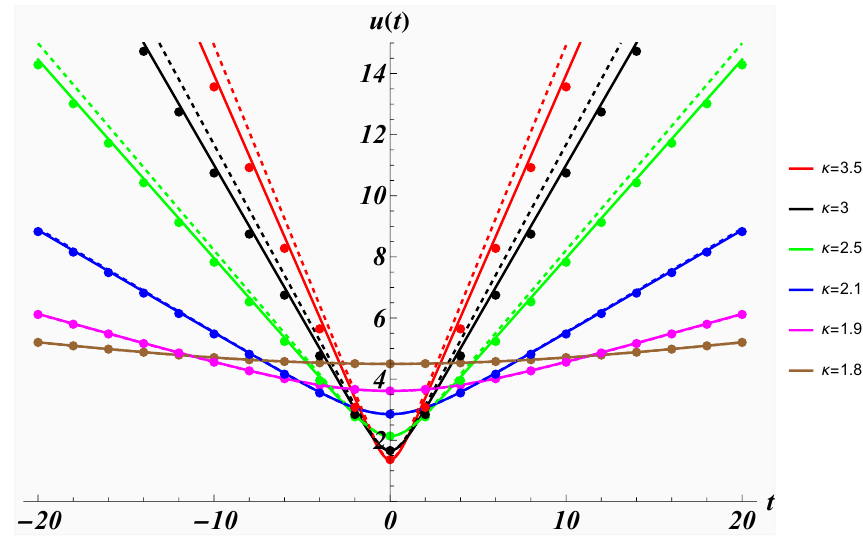
Figure 2 . Collective coordinate u ( t ) as solution of the Euler-Lagrange equation (2.10) for the reduced theory (dashed lines) versus the “exact” expression (3.29) (solid lines) read off from the comparison of the exact two-soliton solution (3.24) with a superposition of two one-soliton solu- tions (3.20) or obtained from the singularity structure of the exact solution (3.31) versus the average value (2.11) with % [ ϕ ] = ϕ